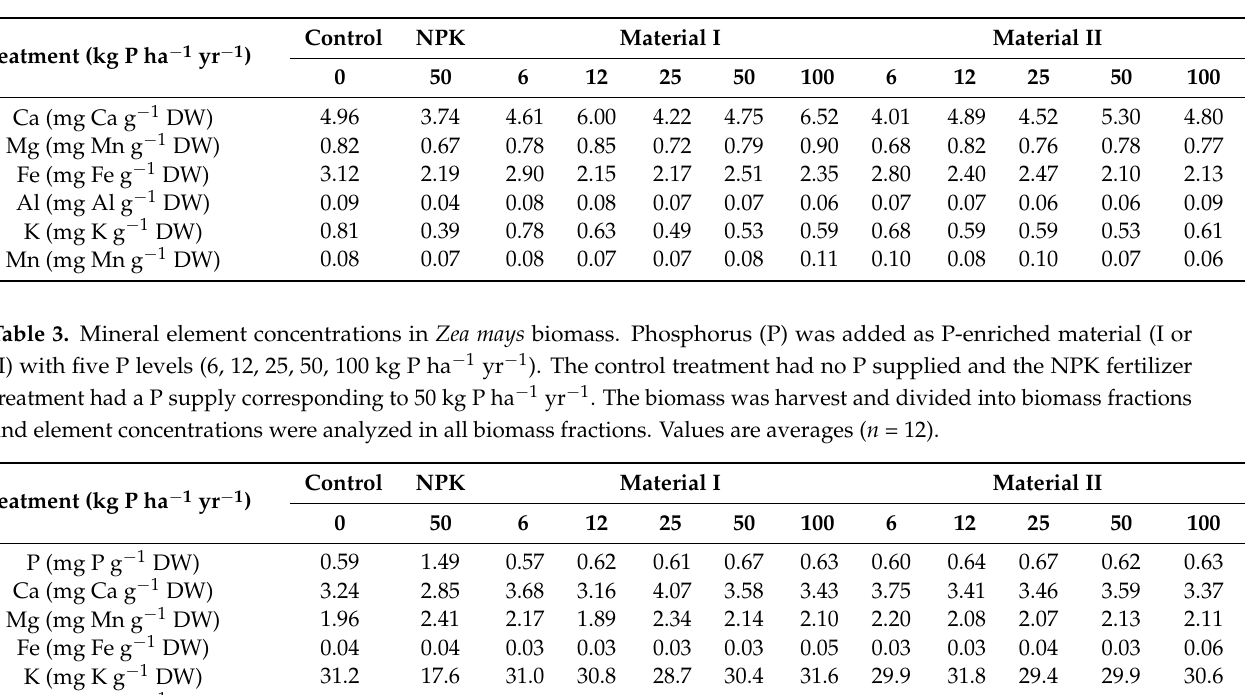
Table 2. Mineral element concentrations in soil samples at the end of the experiment. Phosphorus (P) was added as P-enriched material (I or II) with five P levels (6, 12, 25, 50, 100 kg P ha − 1 yr − 1 ). The control treatment had no P supplied, and the NPK fertilizer treatment had a P supply corresponding to 50 kg P ha − 1 yr − 1 . Values are averages ( n = 3). The soil samples were collected after removing the belowground biomass and homogenizing the soil.